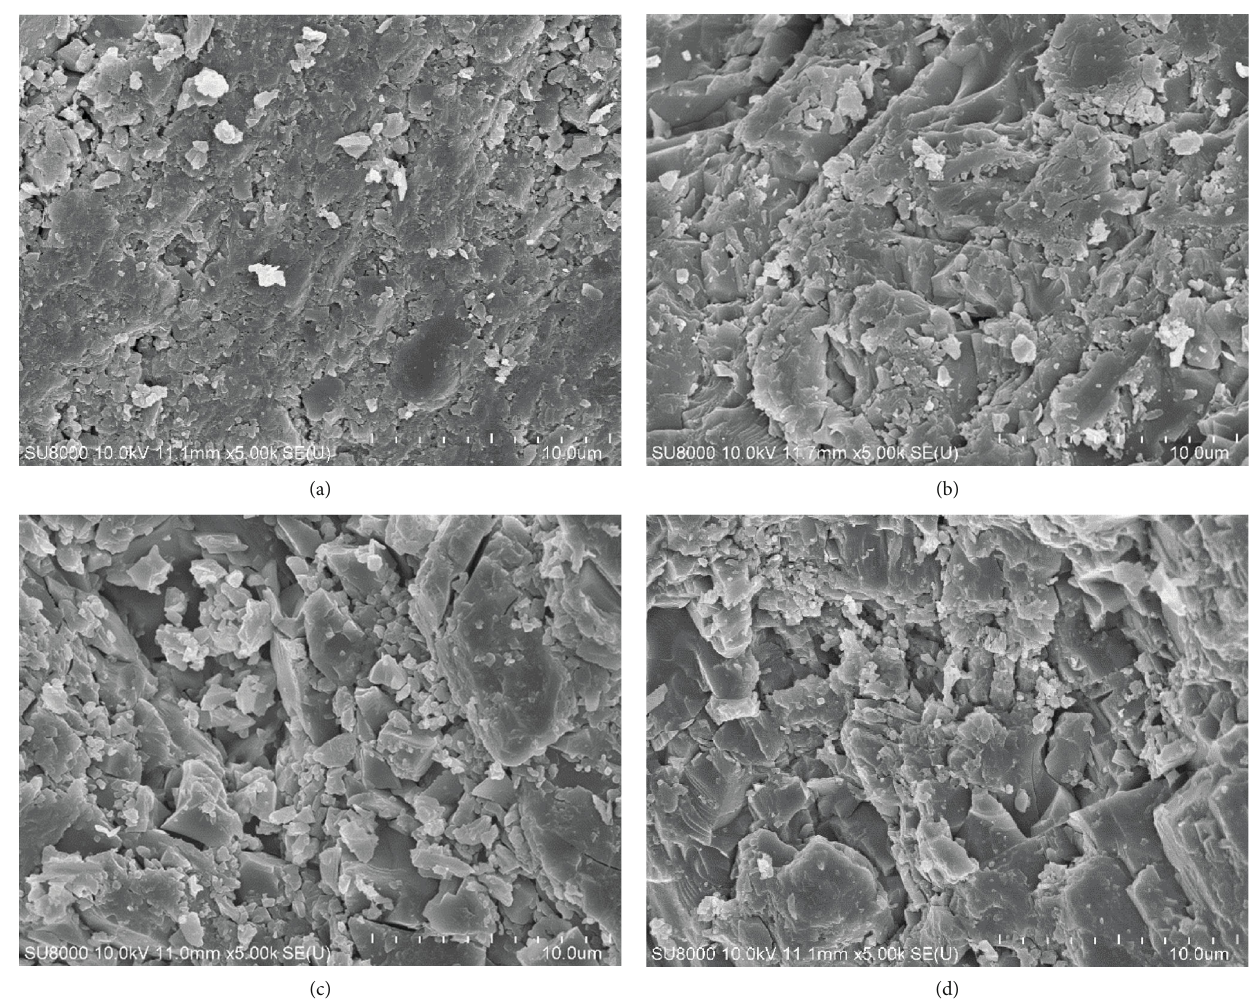
Figure 6: SEM images of fi ssure surface of granite: (a) without immersion, (b) 30 days, (c) 60 days, and (d) 90